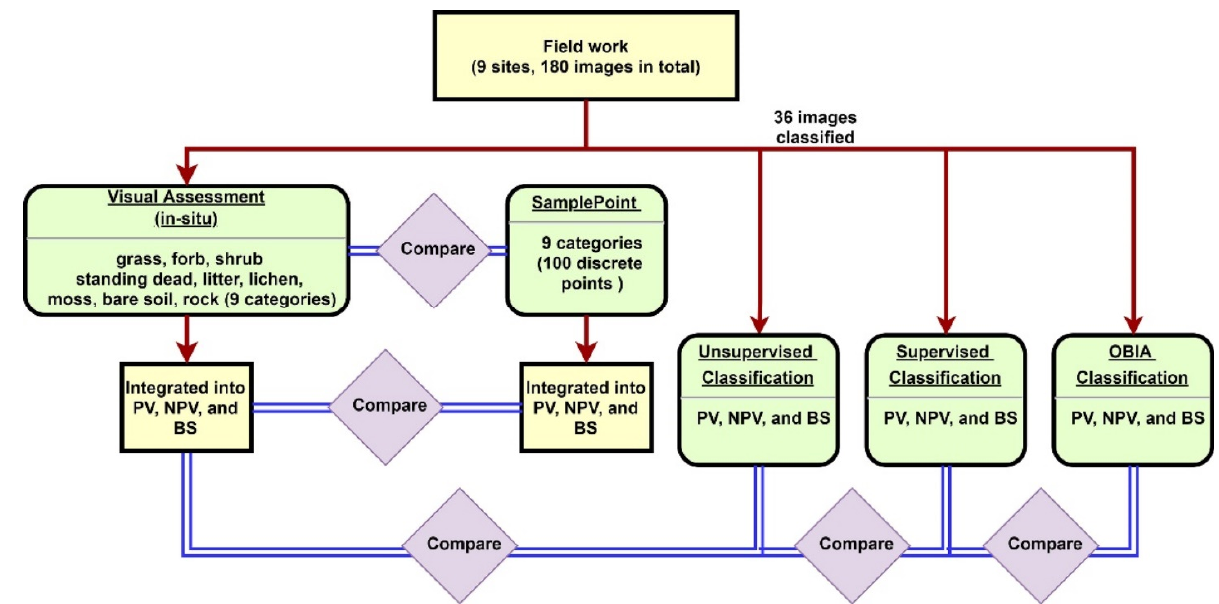
Figure 2. Methodology flowchart.